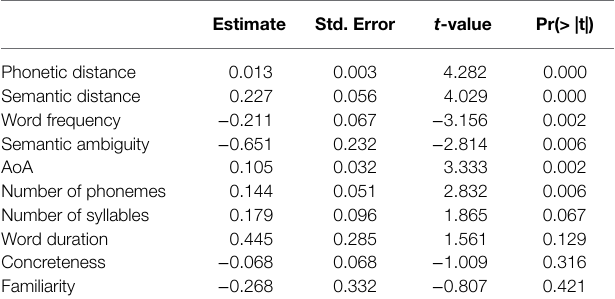
TABLE 4 | Results of separate linear mixed-effects models of the relation between RT and the language measures. Estimate Std. Error t -value Pr(>